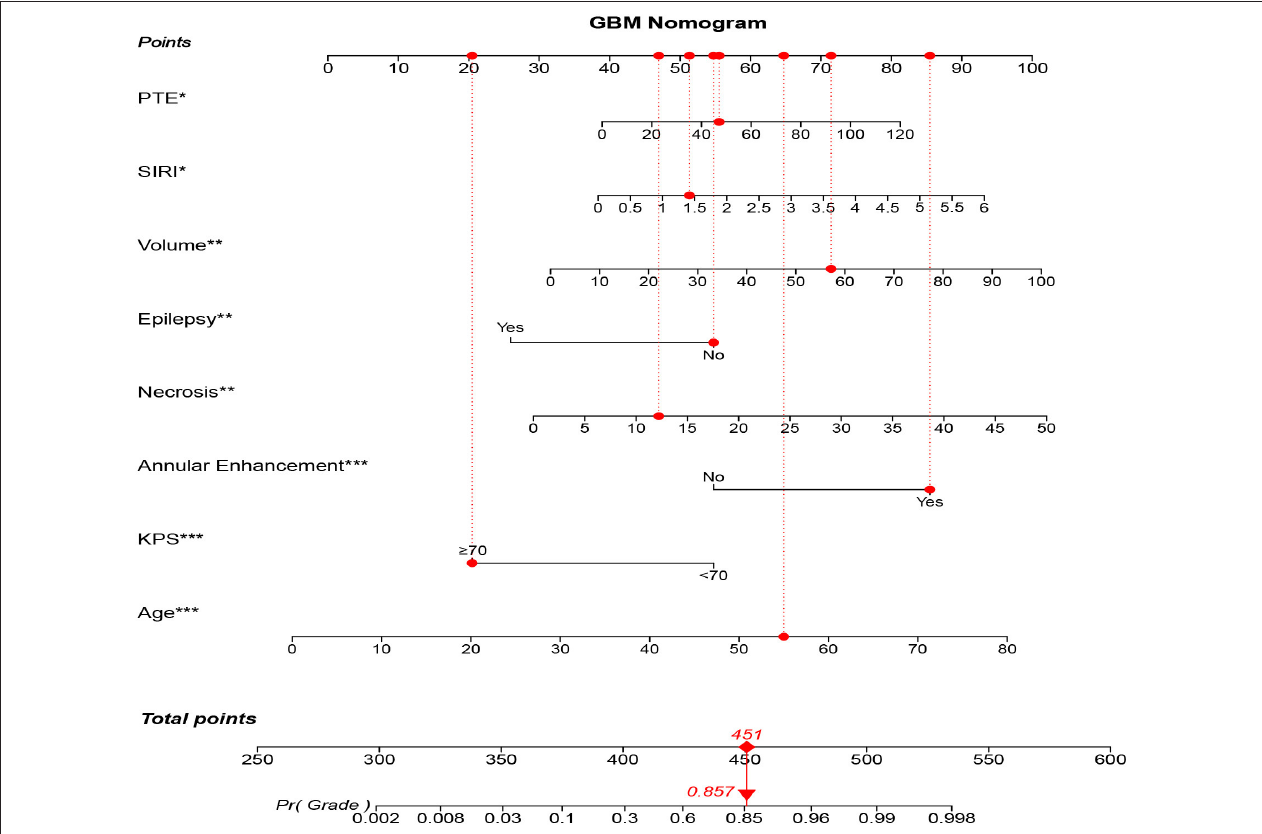
FIGURE 2 | GBM-related nomogram prediction score. GBM-related nomogram was constructed to preoperatively predict GBM for glioma patients, with the age, pKPS, annular enhancement, tumor necrosis volume, pEO, tumor volume, SIRI and PTE. The nomogram showed the probability of having GBM in a randomized